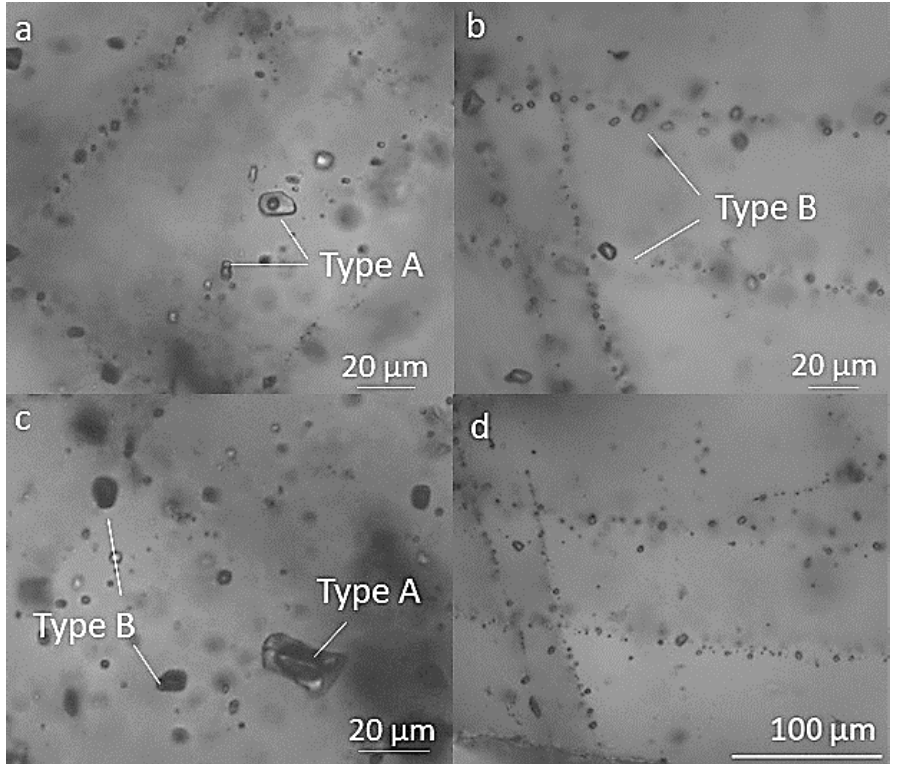
Figure 4. Types of fluid inclusions in quartz from the Dobroe deposit: ( a ) type A, L H2O + V(L) CO2±CH4±N2 ; ( b ) type B, (V(L) CO2±CH4±N2 ), ( c ) coexisting type A and type B fluid inclusions; ( d ) systems of intersecting fractures filled with type B inclusions.